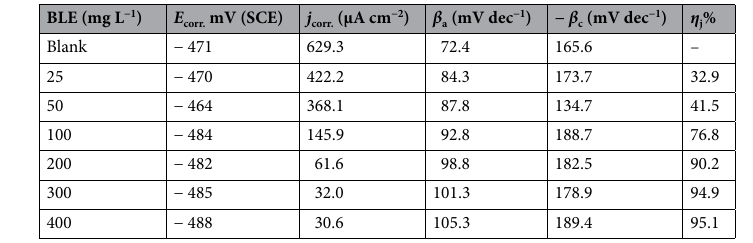
Table 2. Percentage corrosion inhibition efficiency and polarization parameters of varied concentrations of BLE extract for X52-steel in 1.0 M HCl at 298 K calculated by polarization method.